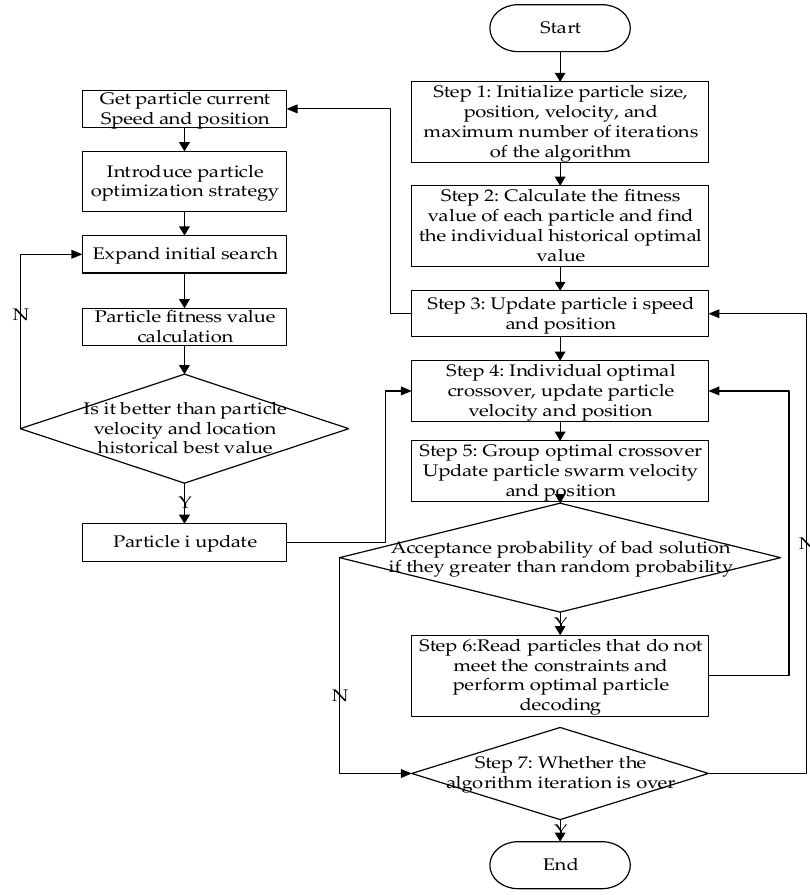
Figure 1. Flow chart of improved PSO.